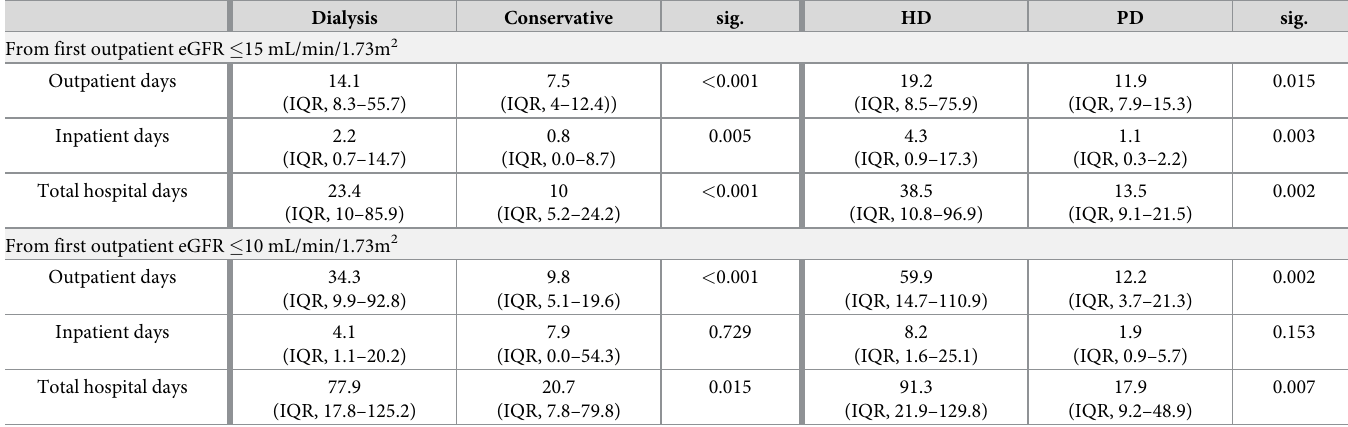
Table 3. Comparisons of annualised number of hospital days and invasive procedures between dialysis and conservative care, and between haemodialysis and peri- toneal dialysis from the baseline of first outpatient eGFR � 15 mL/min/1.73m 2 and first outpatient eGFR � 10 mL/min/1.73m 2 . Key: HD = haemodialysis; PD = peritoneal dialysis. Numbers are expressed as median (interquartile range [IQR]).